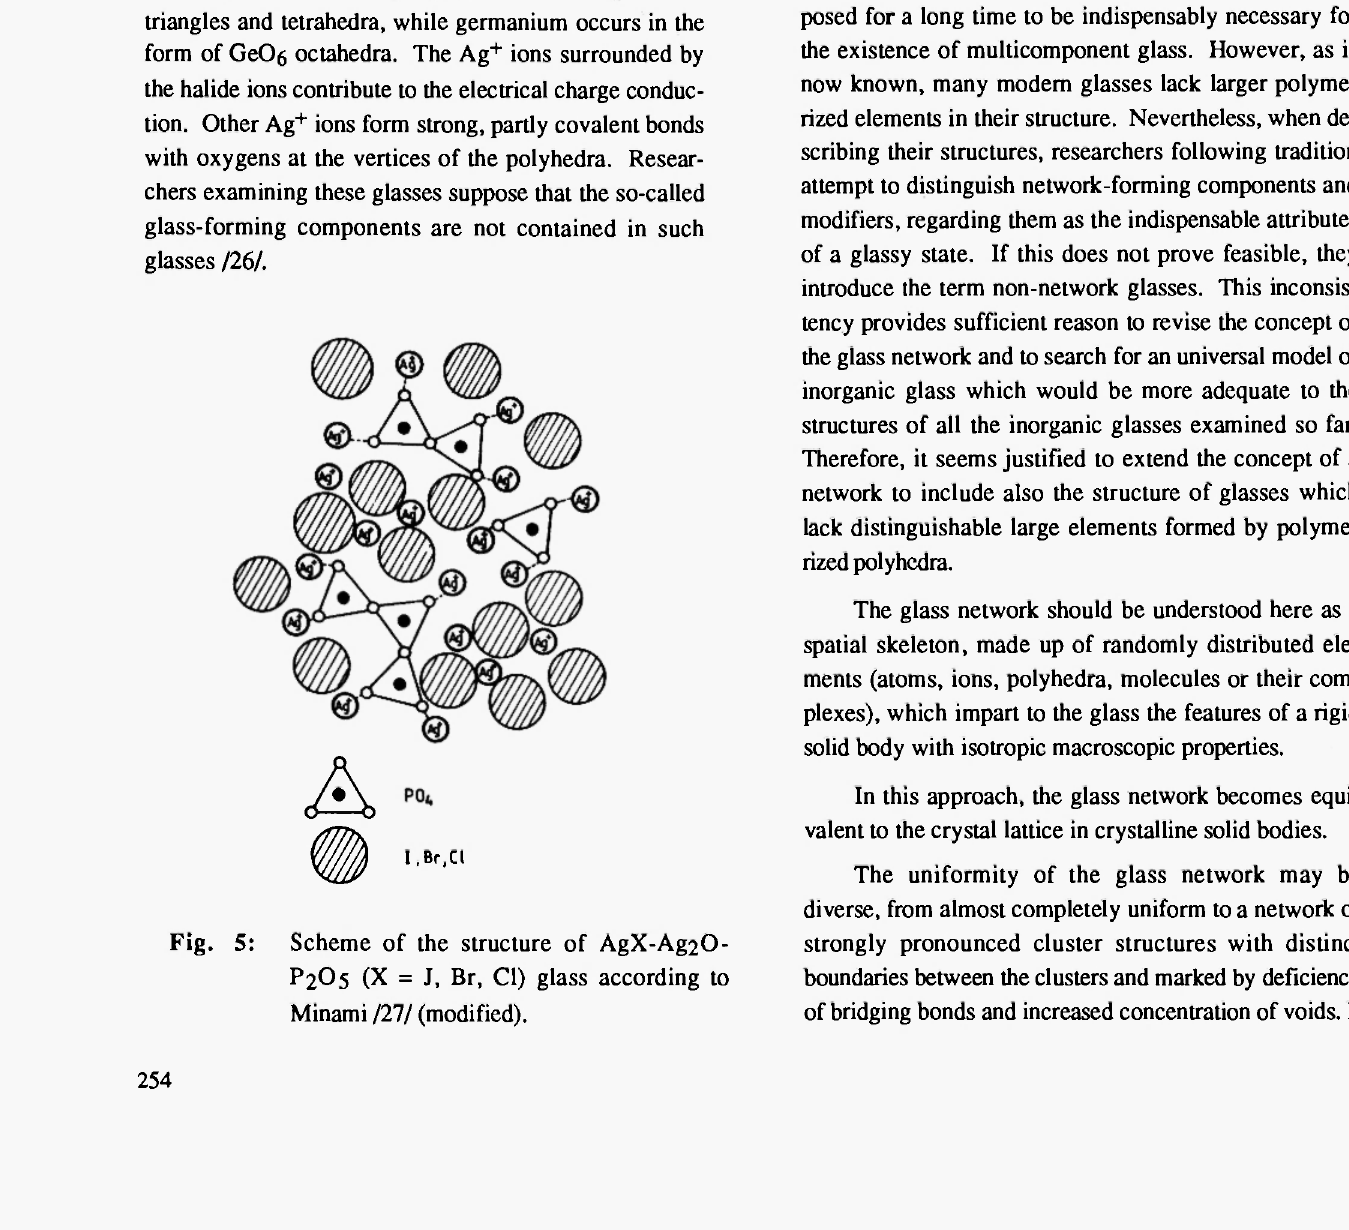
Fig. 5: Scheme of the structure of AgX -Ag2Ü- P2O5 (X = J, Br, CI) glass according to Minami /27/